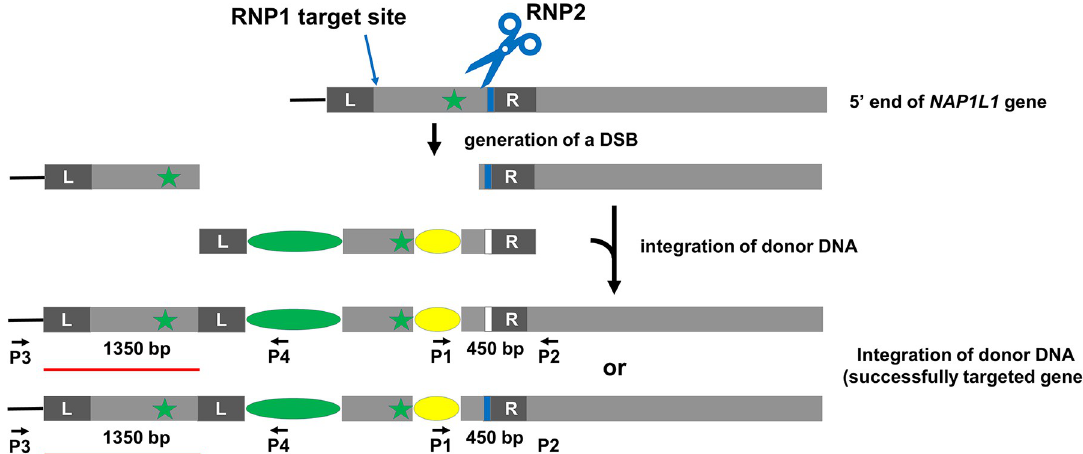
Fig 10. Schematic overview of TIM-based N-terminal tagging of NAP1L1. Two RNPs were used as described in Fig 4. However, the gene was cut by RNP2 only, resulting in an insertion of the donor DNA at that site. A portion (indicated by a red line) of the original gene remains immediately upstream of the drug-resistance cassette. The sizes of the expected PCR products for specific experiments of Figs 8 and 9 are shown between the primers.